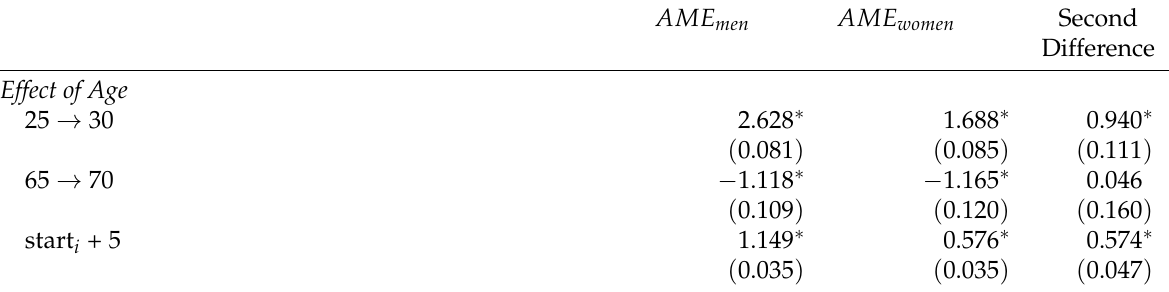
Table 2: Results for how wages are associated with age and gender: tests of average marginal effects (AMEs) and second differences ( N = 30,